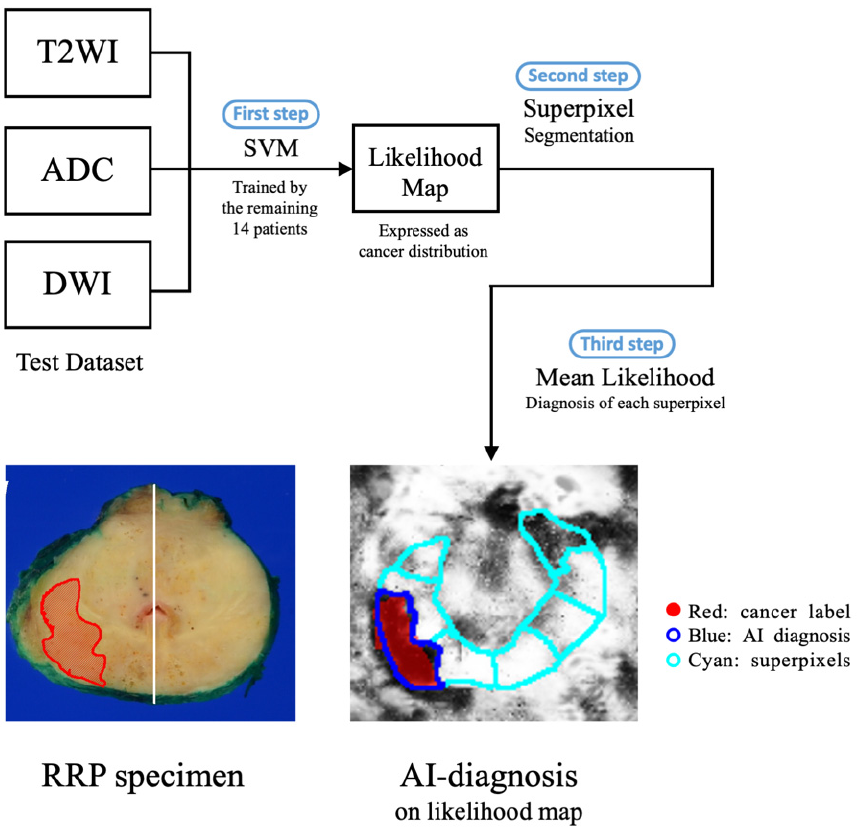
Figure 1. Overview of our AI-based CAD. This procedure included training the SVM, generating the likelihood maps, and superpixel segmentation. The final diagnosis was fully